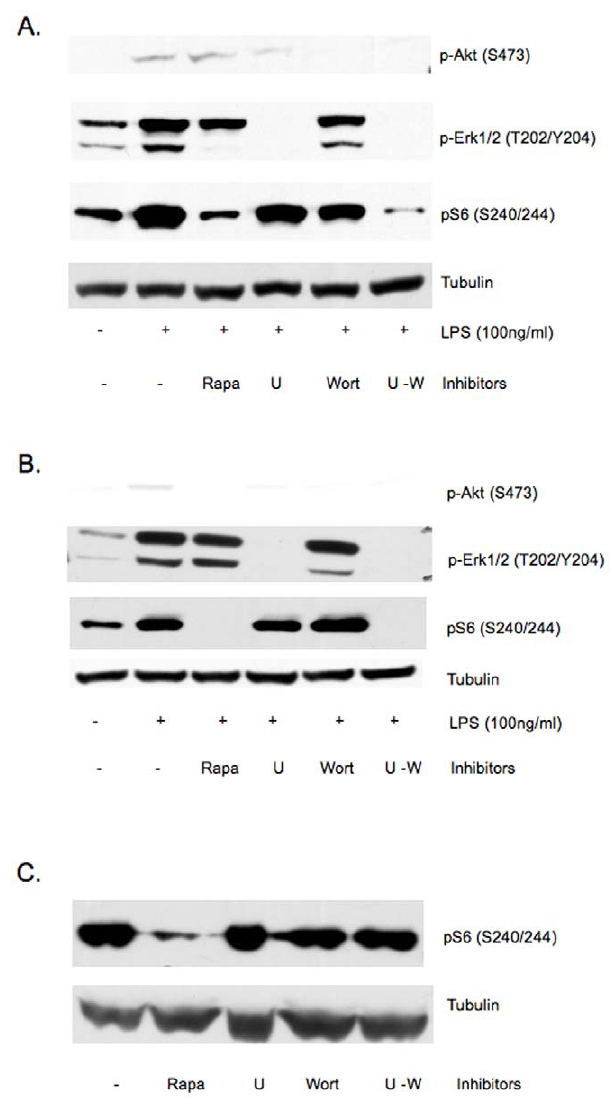
Figure 10. Concurrent inhibition of PI3K and MEK-ERK pathways suppresses LPS-induced mTORC1-S6K activation in macrophages. Representative immunoblots of RAW cells (A) and murine peritoneal macrophages (B) pretreated with vehicle control, 20 nM rapamycin (Rapa), 5 m M MEK1/2 inhibitor U0216 (U), 100 nM wortmannin (Wort), or combination of U0216 and wortmannin (U–W) 30 min prior to LPS stimulation. Cells were harvested 2 hr post LPS. Only the combined Inhibition of MEK1/2-ERK and PI3K-Akt significantly suppressed mTORC1-S6K activation by LPS, as indicated by pS6 levels. The same doses of pharmacologic inhibitors were applied to Tsc2-null MEFs (C), and did not suppress mTORC1-S6K activity as reflected by pS6, suggesting the effects of these compounds are dependent upon